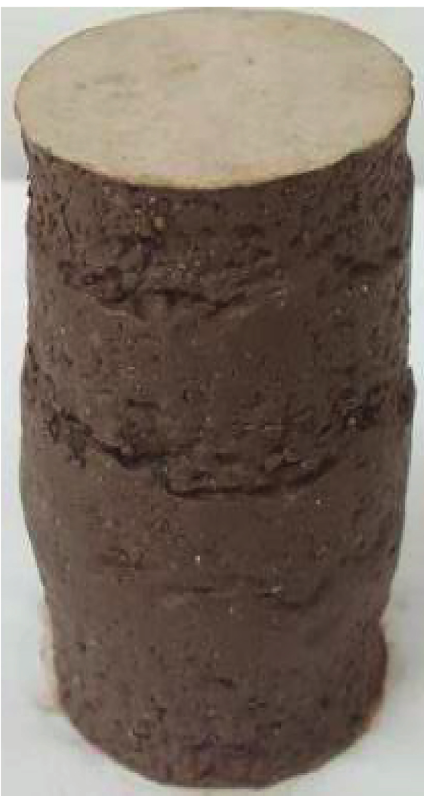
Figure 9: Failure form of the modified